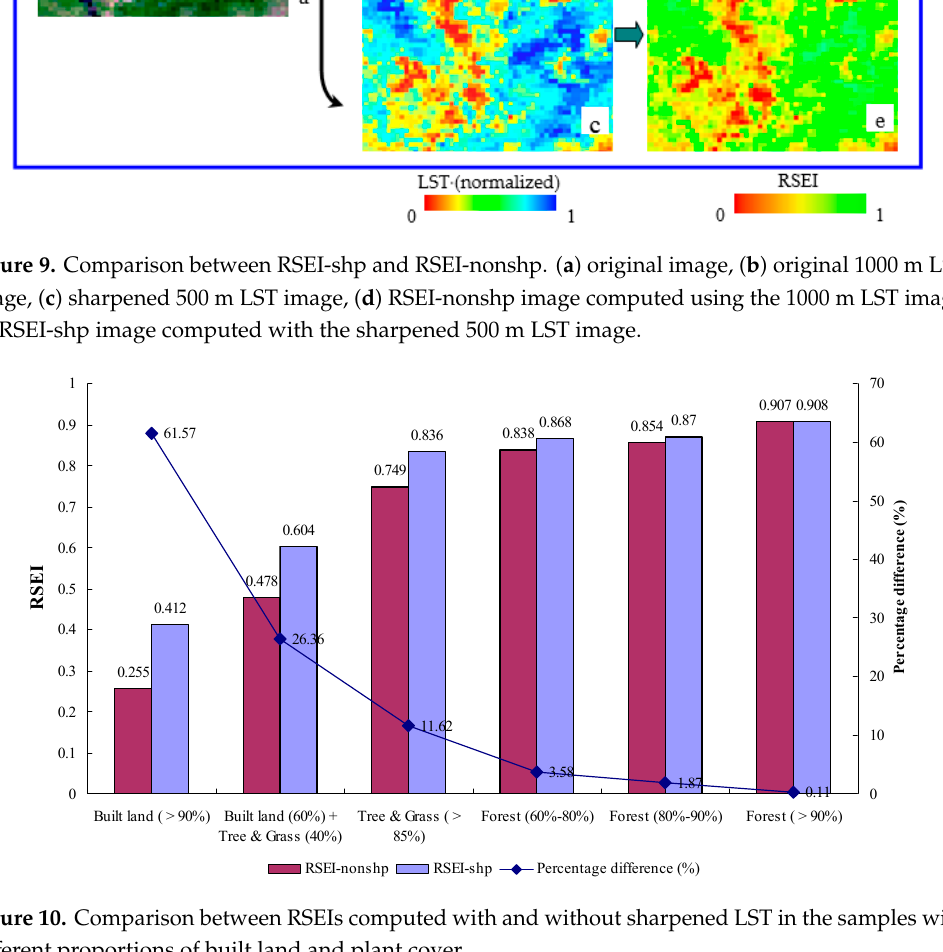
Figure 9. Comparison between RSEI-shp and RSEI-nonshp. ( a ) original image, ( b ) original 1000 m LST image, ( c ) sharpened 500 m LST image, ( d ) RSEI-nonshp image computed using the 1000 m LST image, ( e ) RSEI-shp image computed with the sharpened 500 m LST image.